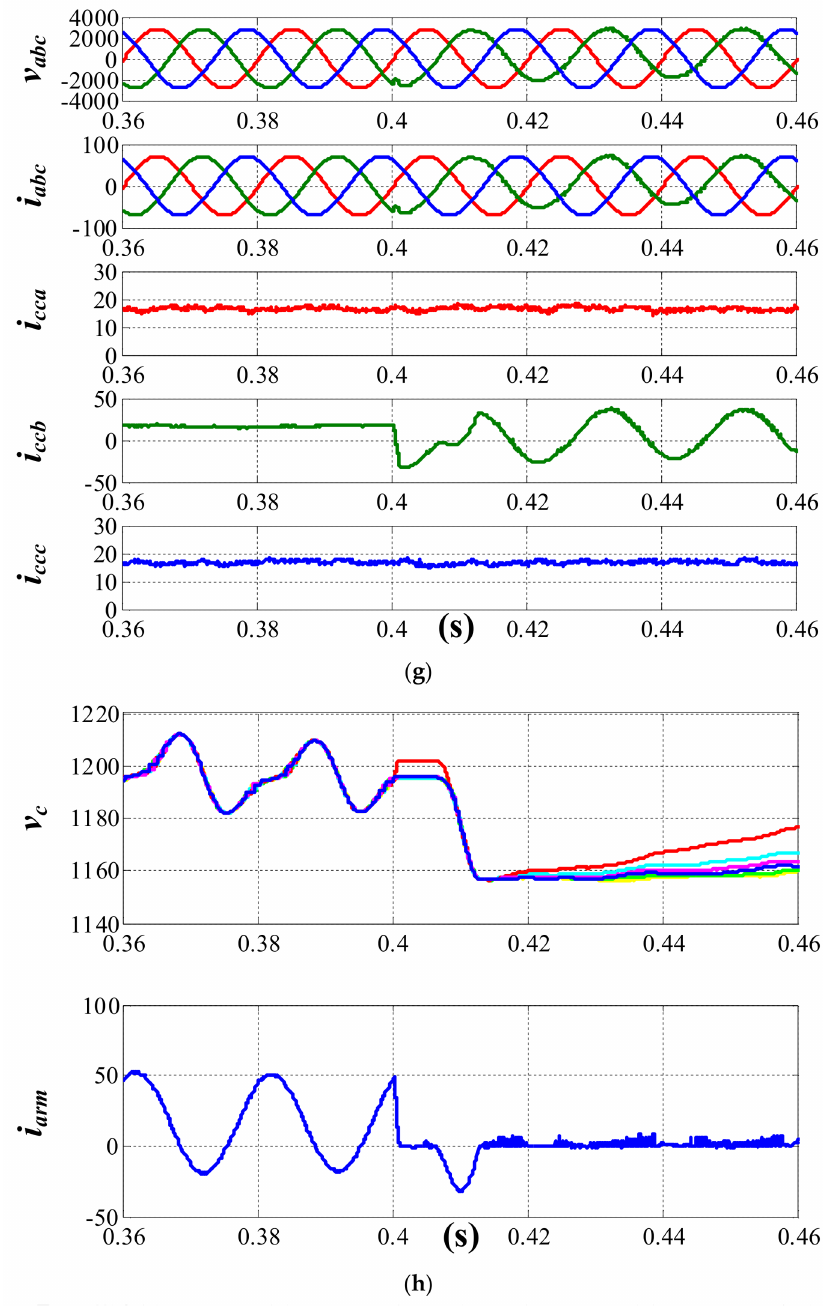
Figure 7. The output voltage, output current, circulation, bridge arm current, and capacitor voltage of an IGBT with an open circuit fault. ( a ) The output voltage, current, and circulation of the B phase upper bridge arm module S 1 ; ( b ) The sub-module capacitance voltage and bridge arm current of the B phase upper bridge arm module with an S 1 open circuit; ( c ) The output voltage, current, and circulation of the B phase upper bridge arm module with an S 2 open circuit fault; ( d ) The sub-module capacitance voltage and bridge arm current of the B phase upper bridge arm module with an S 2 open circuit fault; ( e ) The output voltage, current, and circulation of the B phrase lower bridge arm sub-module with an S 1 open circuit fault; ( f ) The sub-module capacitance voltage and bridge arm current of the B phase lower bridge arm module with an S 1 open circuit fault; ( g ) The output voltage, current, and circulation of the B phase lower bridge arm module with an S 2 open circuit fault; ( h ) The capacitance voltage and the bridge arm current of the B phase lower bridge arm module with an S 2 open circuit